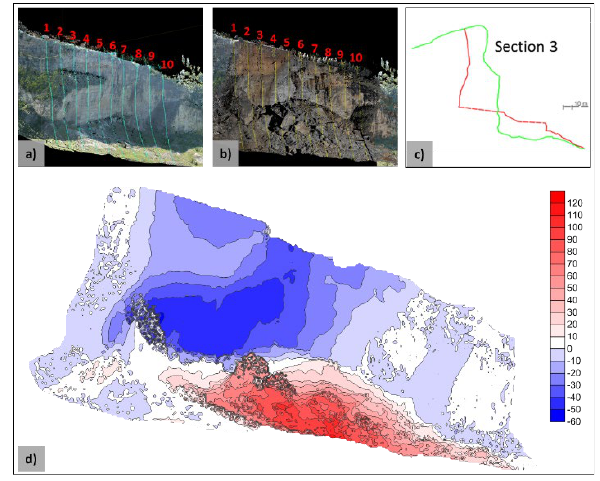
Figure 5. Comparison between point clouds before and after the 2014 slide: a) vertical sections on the point cloud before the failure; b) vertical sections on the point cloud after the failure; c) example of profiles obtained from the cloud sections; d) The comparison of the rock-face pre and post event